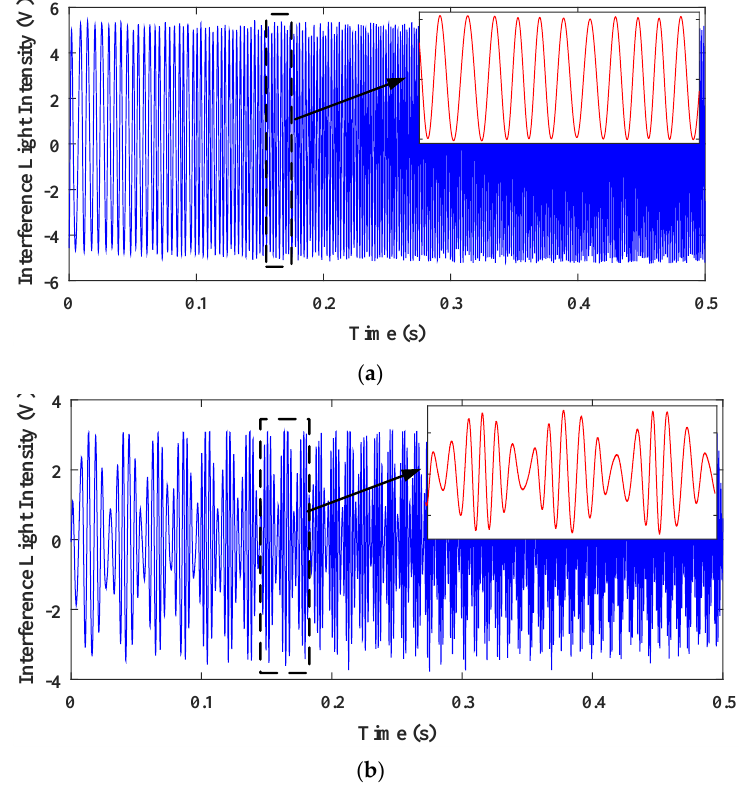
Figure 22. The interferogram signals acquired in time domain with H∞ control. ( a ) Reference light. ( b ) Testing light. (a)The reconstructed interferogram of the testing light in spatial domain with H control